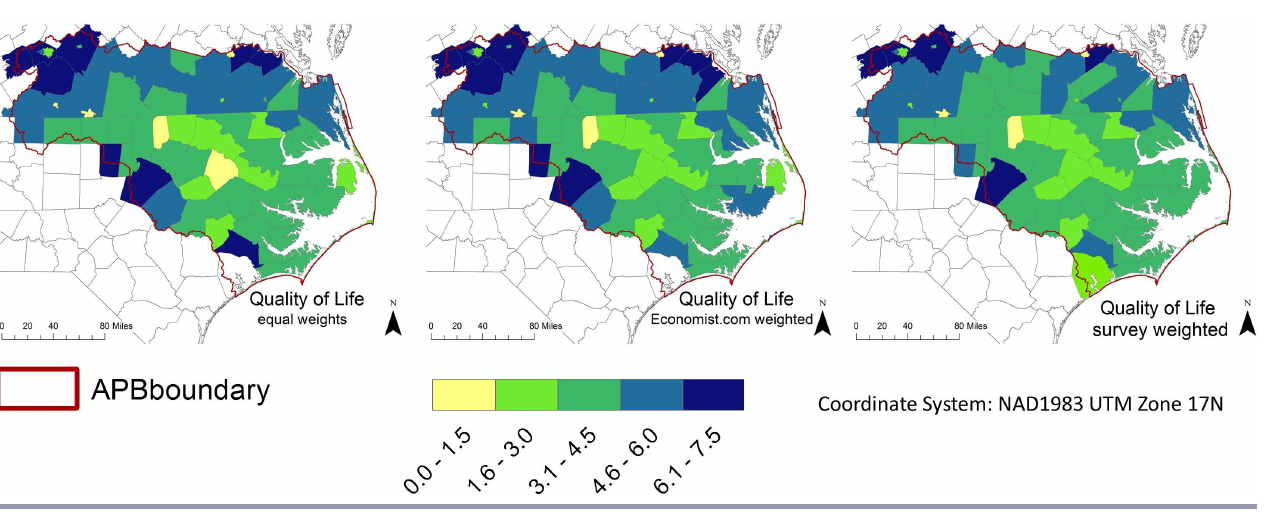
Fig. 1 . The Economist’s Intelligence Unit Quality of Life Index mapped for counties within the Albemarle Pamlico basin. The index was mapped with no factor weighting (left), weights according to The Economist surveys (middle), and weights according to the QoL surveys